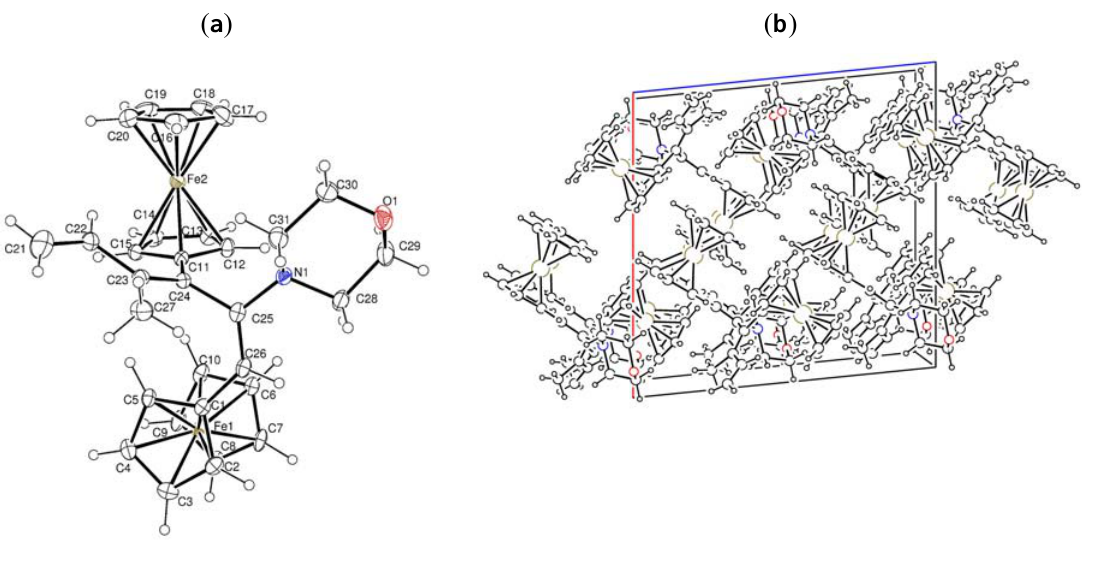
Figure 2. ( a ) X-ray crystal structure of 10a ; ( b ) Crystal packing of 10a .